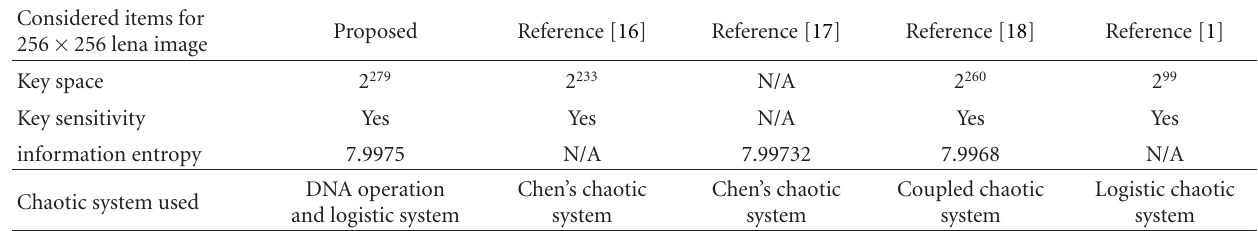
Table 2: Comparison with other chaos-based encryption algorithms.